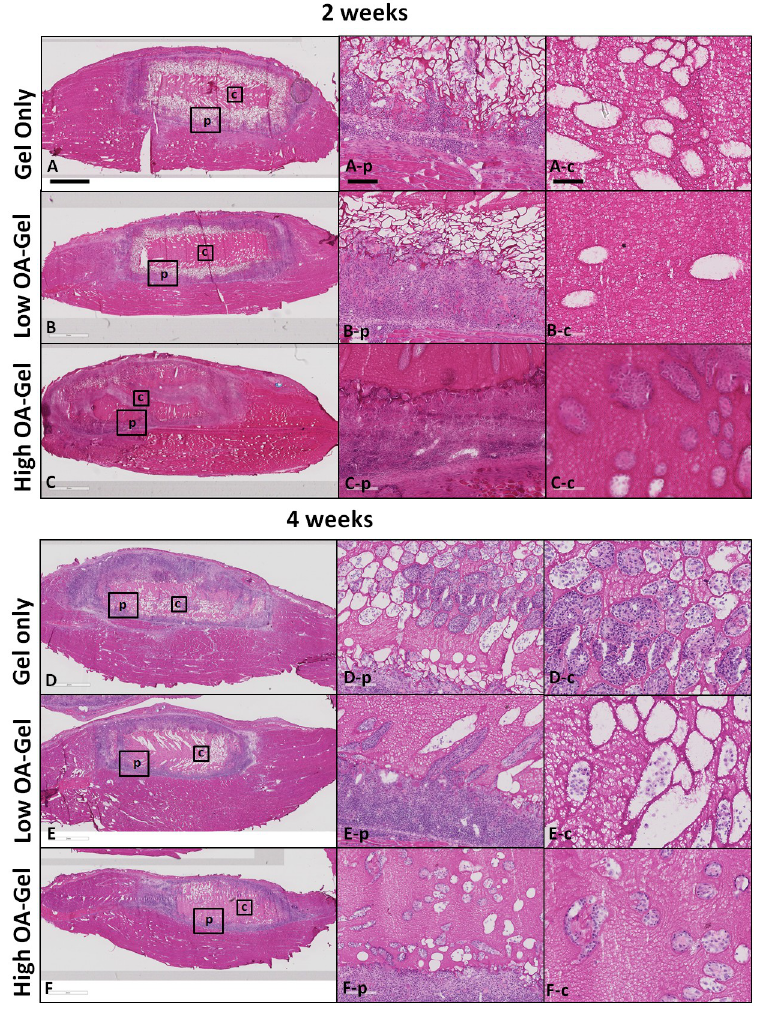
Fig 3. Representative sections of 2 week and 4 week TA muscle explants treated with gel only, low OA and high OA gels (H&E staining). In all groupsat both time points, remnants of gel encapsulated by a thick cell layer ( A - E ), in which the majority of the cell populationwas inflammatory cells ( A-p to F-p ) was observed. No to scant cells were observedin the center of the gels at 2 weeks ( A-c to C-c ). At 4 weeks, a greater degree of cellularinvasioninto the center of the gels was observed ( D-c to F-c ) than at 2 weeks. Scale bar is 2mm in A-F, 200 μ m in A-p through F-p , and 100 μ m in A-c through F-c .